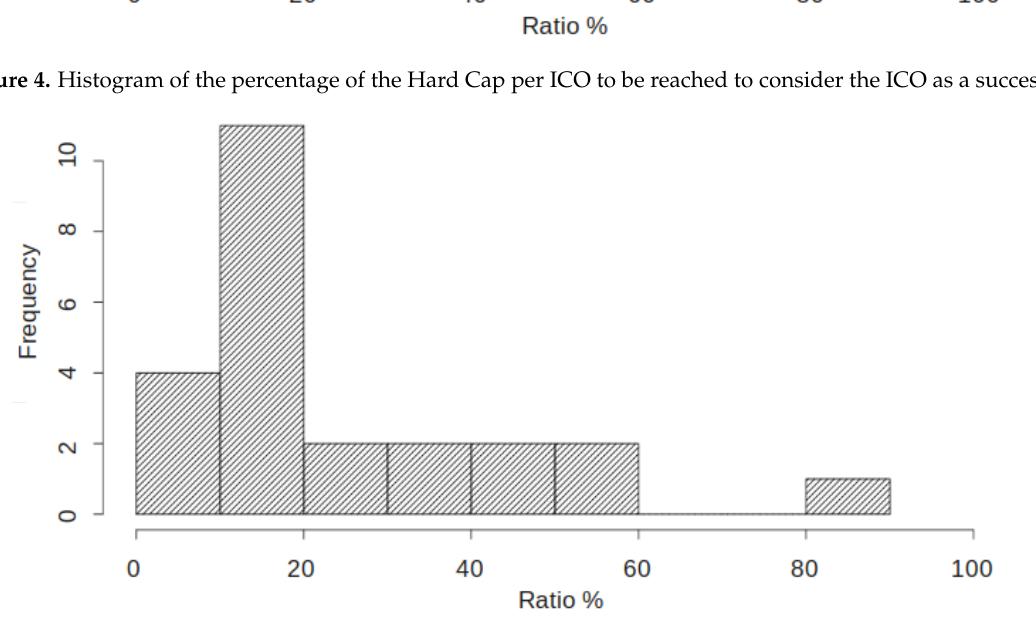
Figure 5. Histogram of the percentage of the Hard Cap per Agile ICO to be reached to consider the Agile ICO as a